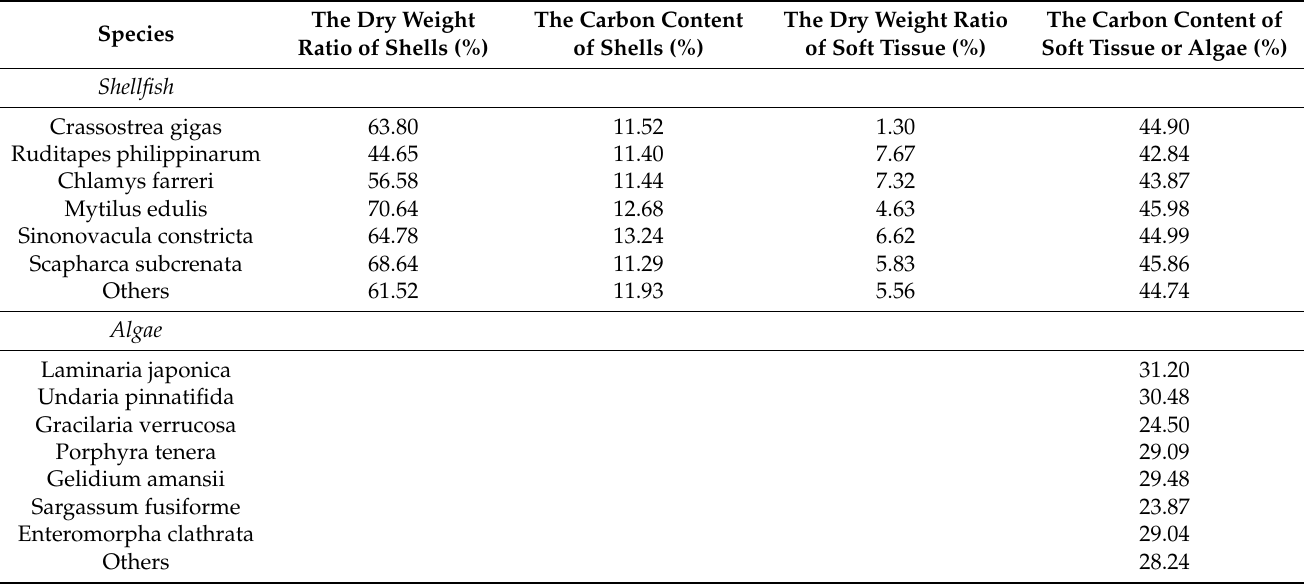
Table 1. Biological parameters used in the model